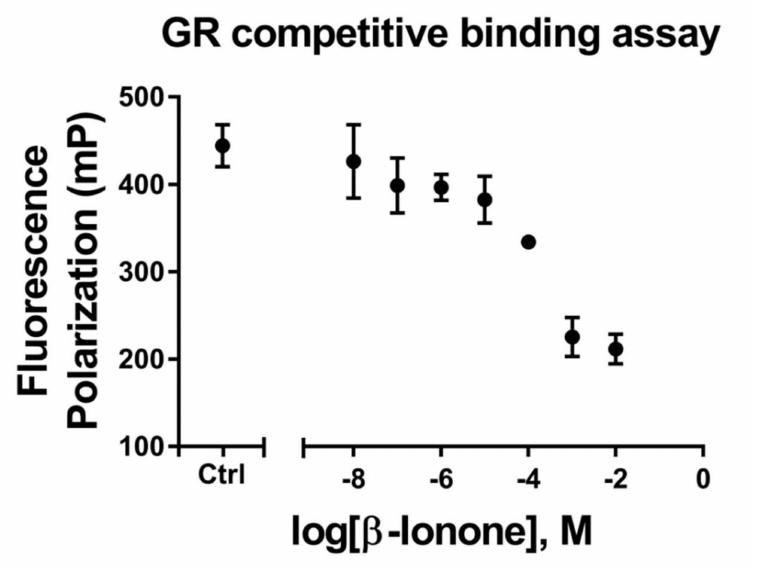
Figure 4. The inhibitory influence of β -ionone on glucocorticoid binding to glucocorticoid receptors (GRs). The human-GR–fluormone complex was incubated with either vehicle or various concentra- tions of β -ionone (10 − 8 –10 − 2 M) for 2 h, and fluorescence polarization was measured. Values are shown as mean ± standard error of the mean (SEM) of three